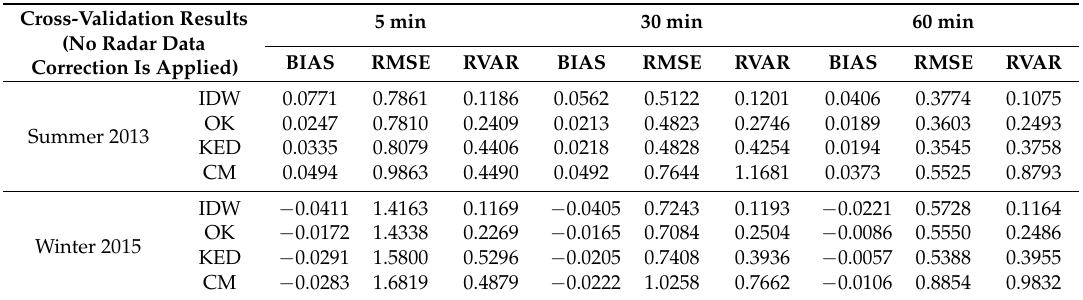
Table 6. Interpolation Performance metrics results for IDW, OK, KED and CM (BIAS in mm/h, RMSE and Rvar are without